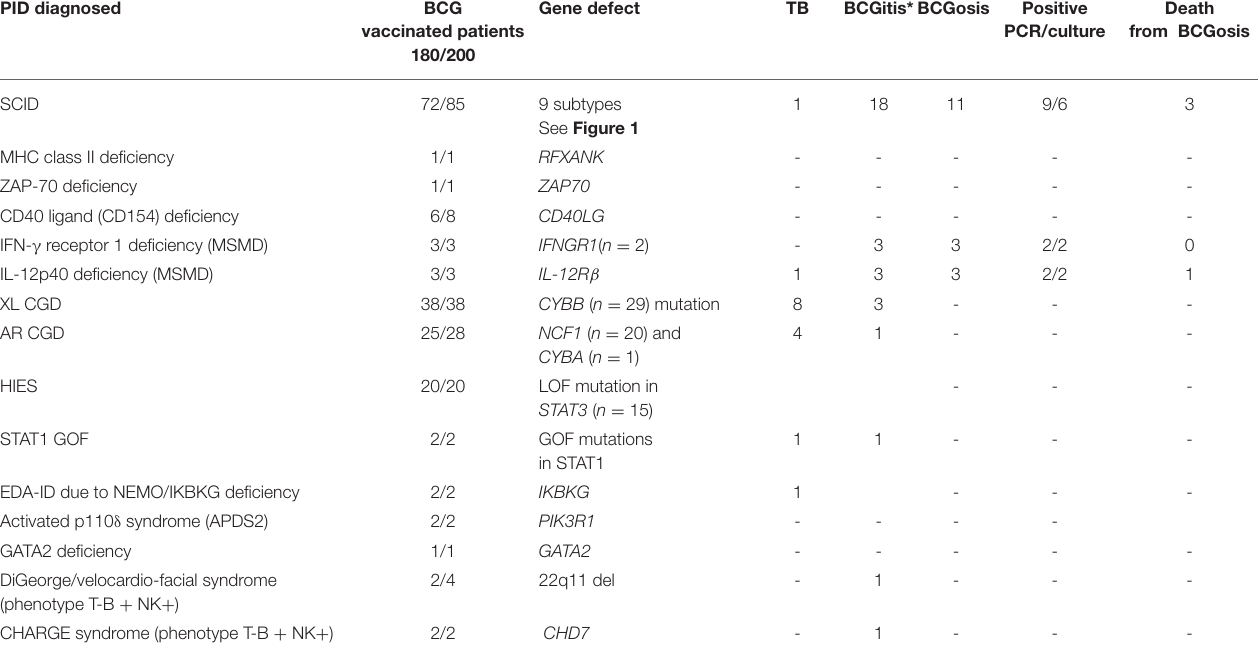
TABLE 1 | BCG and other mycobacterial complications in PID patients susceptible to BCG infection hospitalized at